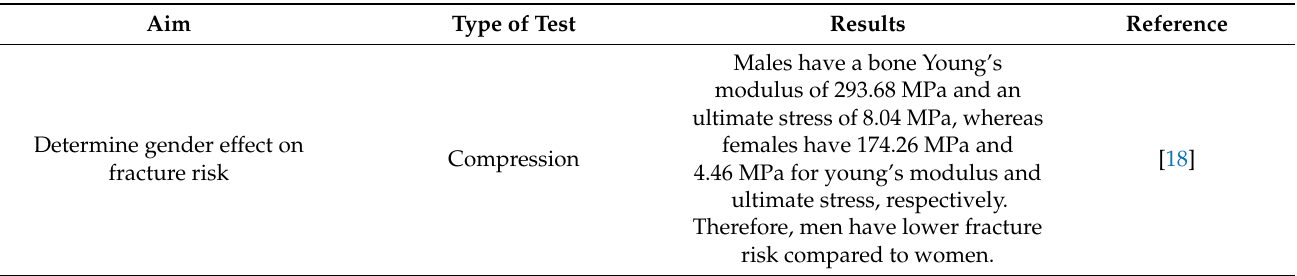
Table 2. Mechanical testing